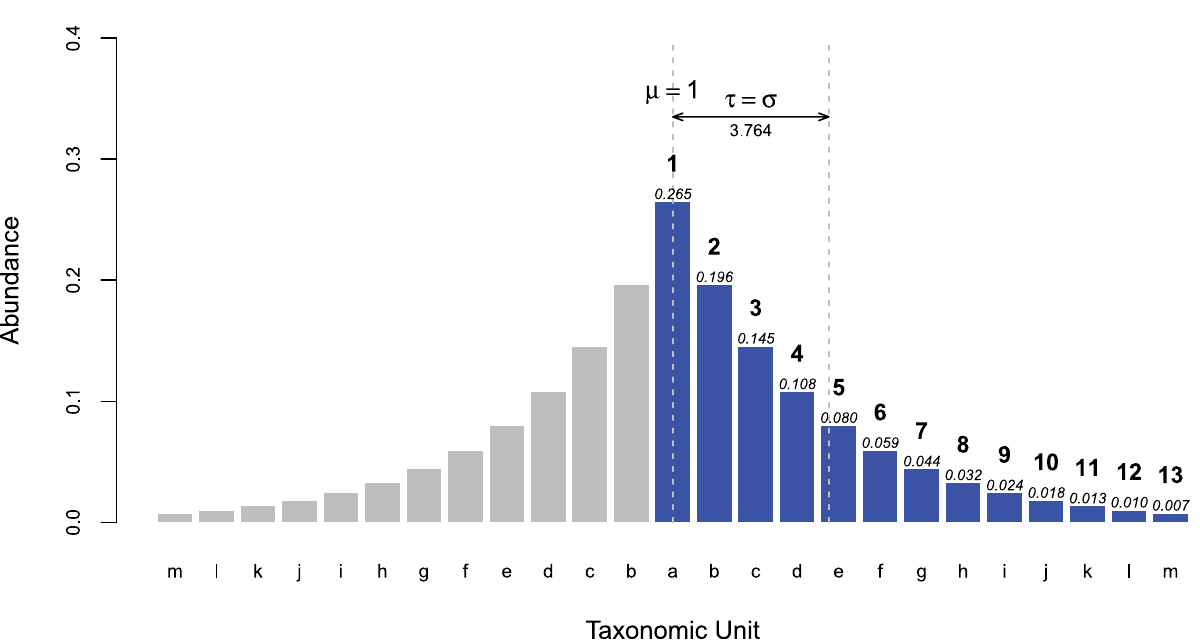
Figure 8. Relationship between the Tail statistic, t , and Standard Deviation, s . t is the standard deviation of the rank abundance curve after reflection around the most dominant taxonomic unit, i =1. The blue bars represent the rank abundance curve. Above each bar, the probability, Pr[ i ], of the i th most dominant taxonomic unit has been labelled in italics. The natural numbers labelled in bold above the blue bars represent the rank, i , of each taxonomic unit. The name of each taxonomic unit is labelled along the x-axis. The grey bars represent the mirror image of the rank abundance curve. Treating i =1of the symmetric distribution as m =1, the standard deviation, s , is then 3.764, which also represents t for this rank abundance curve and